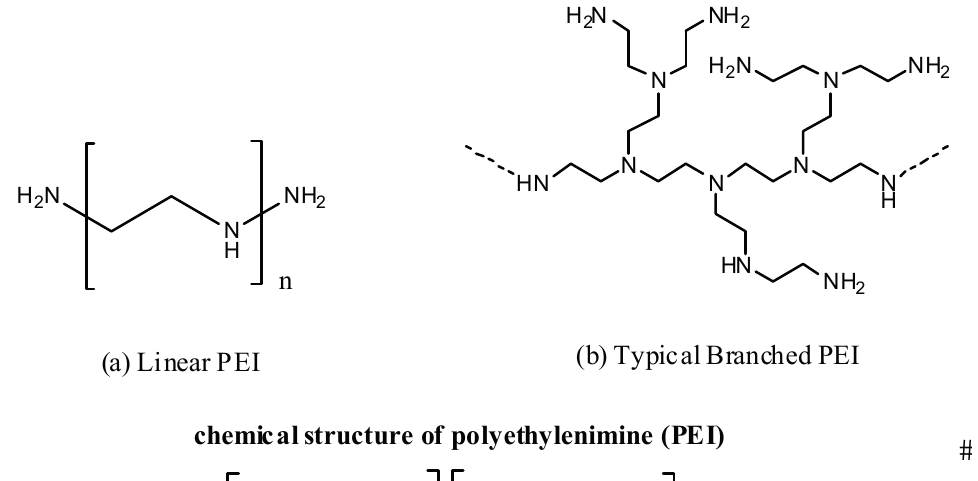
Figure 3. Chemical structures of Polyethylenimine (PEI) ( a , b ), Chitosan ( c ) and Poly(lactic-co-glycolic acid) (PLGA) ( d